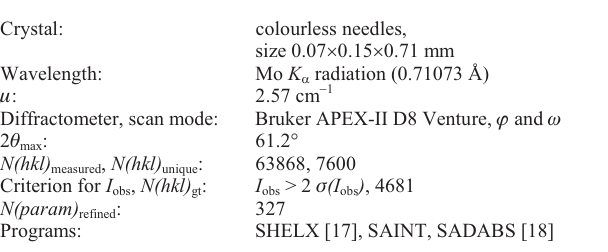
Table 1. Data collection and handling.